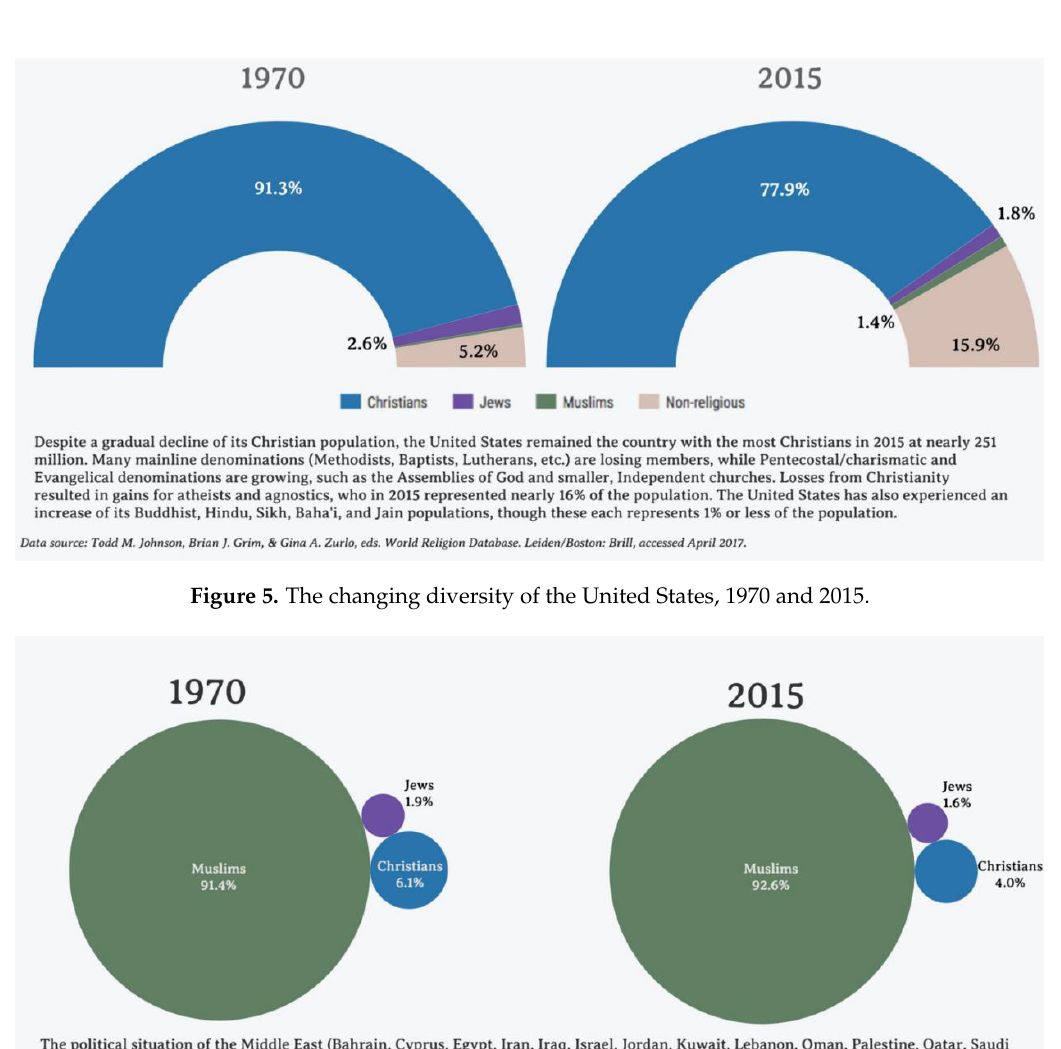
Figure 6. Religious diversity in the Middle East, 1970 and 2015.